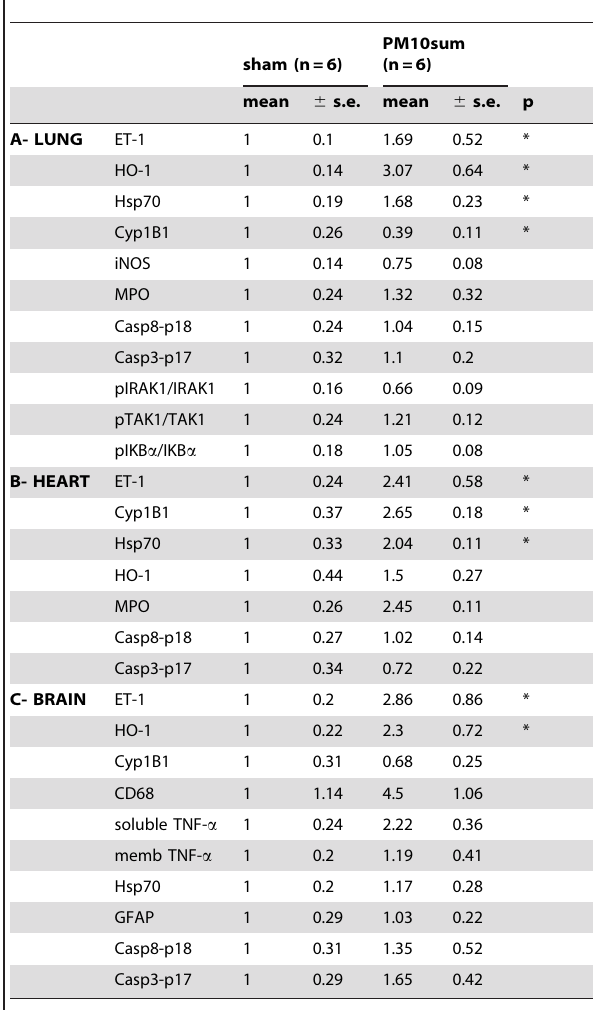
Table 2. Lung gene expression.